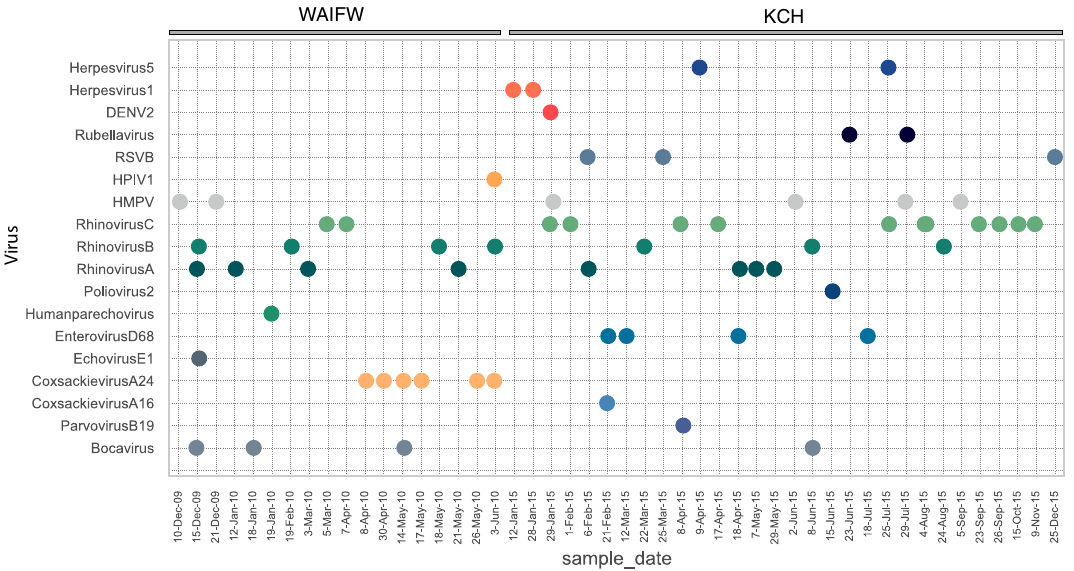
Figure 5. The timeline of viruses identified in the household cohort and KCH pneumonia patients. The viruses detected in the study (by row) were plotted against the date from which samples were collected (by column). Each virus was presented as a different colour. All the positive samples from household cohort were from 10 December 2009 to 3 June 2010, while positive samples from KCH patients were from 12 January 2015 to 25 December